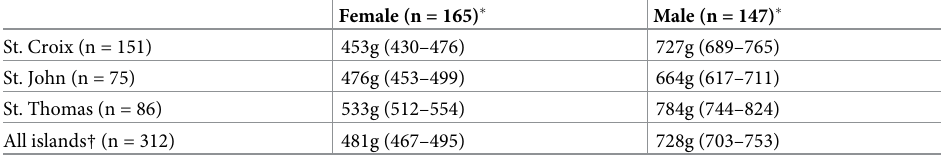
Table 2. Mean weight in grams (95% CI) of small Indian mongooses ( Urva auropunctata ) sampled (n = 312)— United States Virgin Islands, 2019–2020.